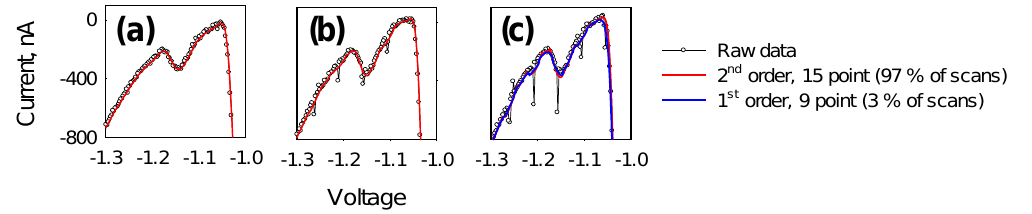
Figure 2. Signal processing of voltammetry scans. Varying instrumental noise imprinted negative current excursions during measurement and necessitated data smoothing to correctly measure the Co(DMG) 2 reduction peak at − 1.15V. For mild (a) and moderate (b) noise levels, a second-order, 17-point smoothing was applied (red line, 97% of scans). Increases in noise caused this routine to overestimate peak height ( c , red line), and a first-order, 13-point smoothing was applied instead ( ∼ 3% of scans, blue